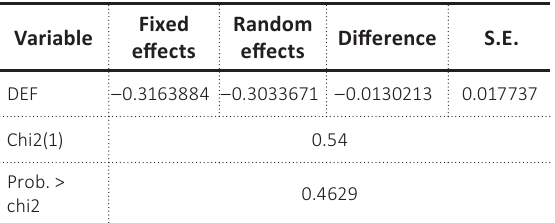
Table 4. Hausman test results